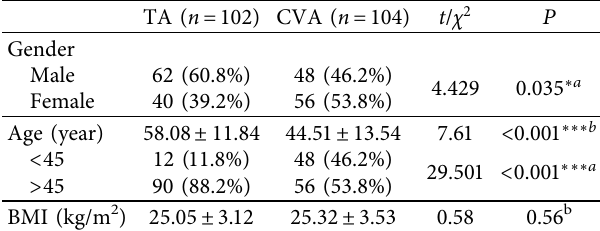
Table 1: The demographic characteristics of TA and CVA